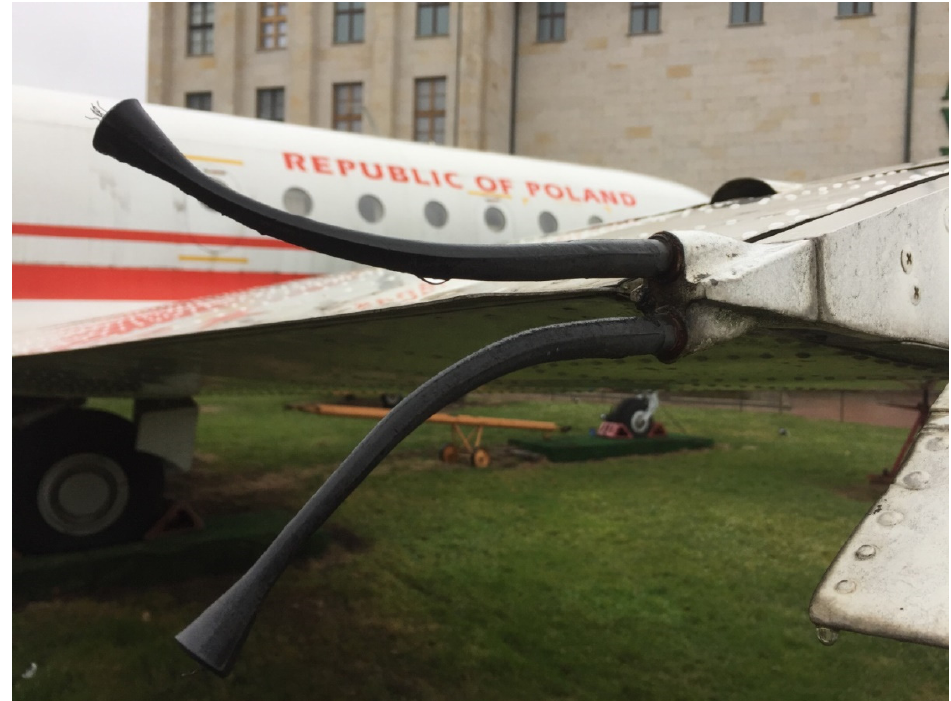
Figure 1. Electrostatic dischargers permanently riveted onto the rear part of the wing of the Yakovlev Yak-40 no. 044 (Polish Air Force); the rubber insulation, expanding at the end, moves away from the corona-susceptible wire bundles from the aircraft’s structure; the wire bundles are easily noticeable at the ends of the cables. The airplane has such dischargers affixed on both wings and on the upper part of the vertical stabilizer.